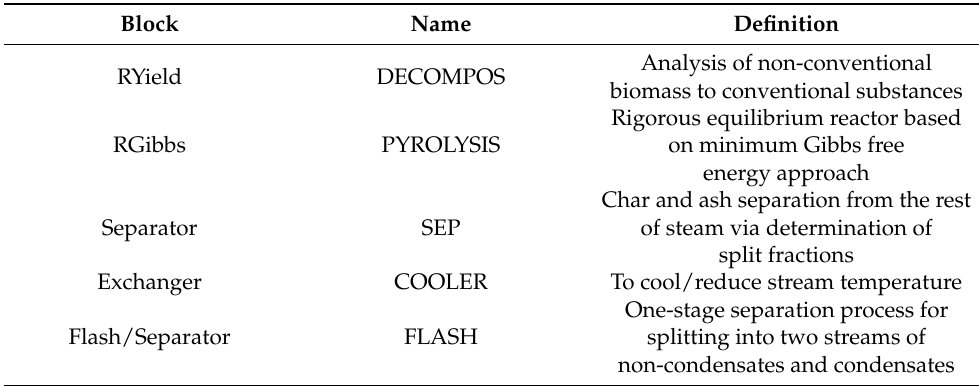
Figure 4. Flowchart of the simulation model for biomass pyrolysis developed using Aspen Plus based on the TE approach. Table 2. Definition of Aspen Plus operational units employed in simulation.